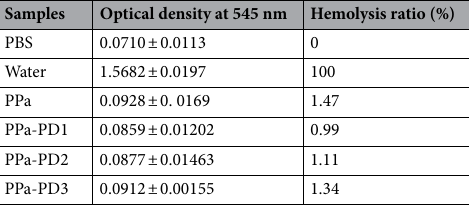
Table 1. Hemolysis caused by different conjugates (5 µg). Standard deviation is calculated from three samples.